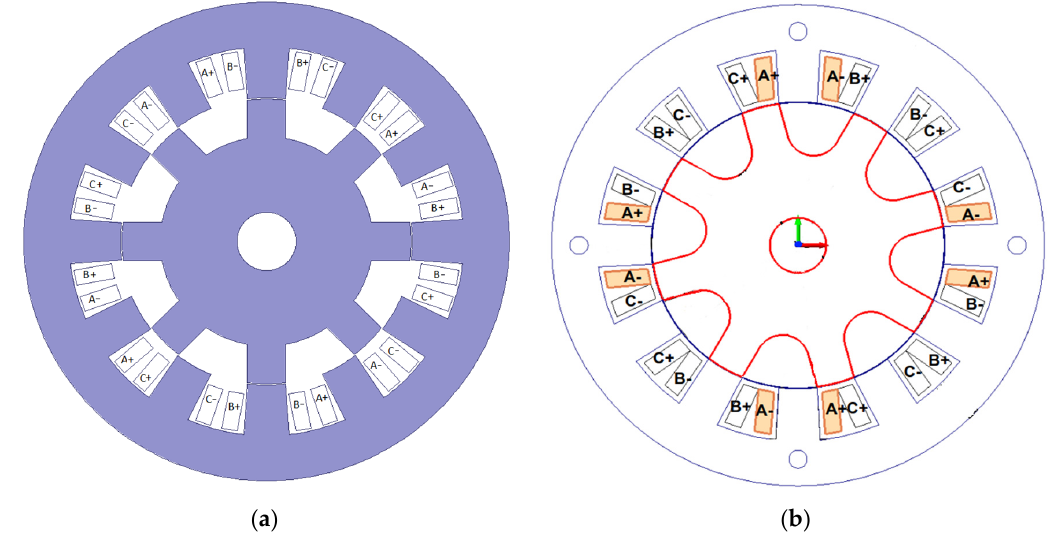
Figure 1. ( a ) Modified Emerson Electric motor structure; ( b ) developed motor with soft magnetic composite (SMC) rotor and stator [32].